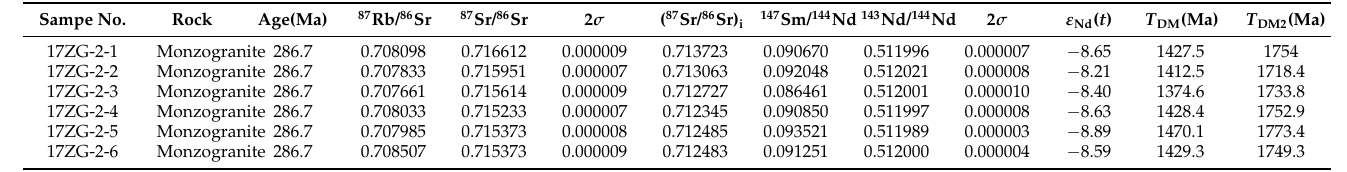
Table 4. Whole-rock Sr-Nd isotopic composition of the Zhaojinggou monzogranite, Inner Mongolia.